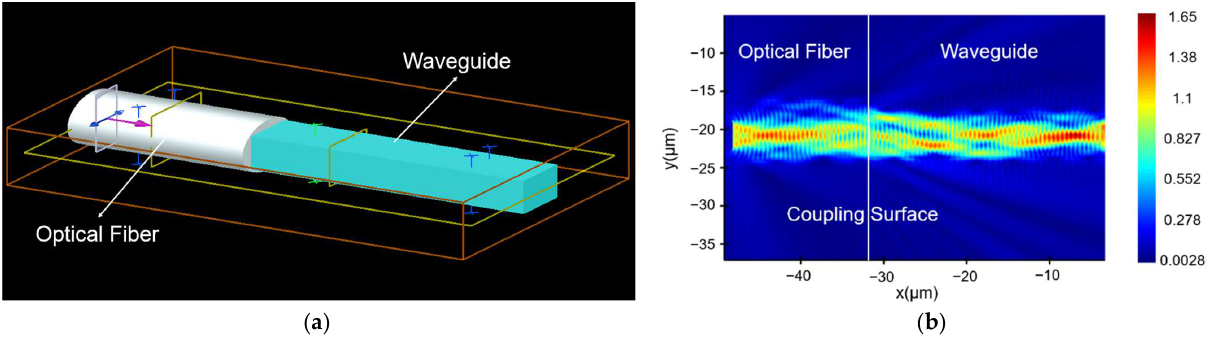
Figure 6. ( a ) Modeling of fiber-waveguide coupling; ( b ) optical field distribution of fiber-waveguide coupling.